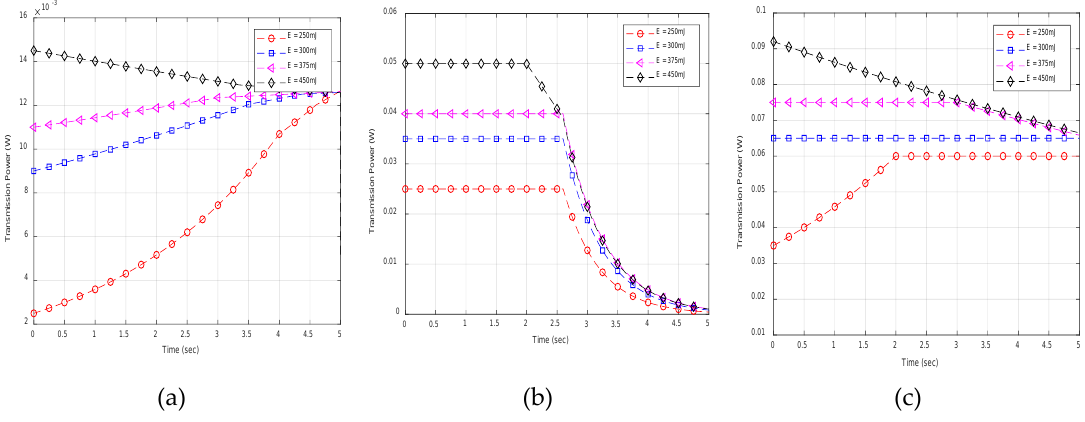
Figure 8. Transmit power with varying battery energy levels.